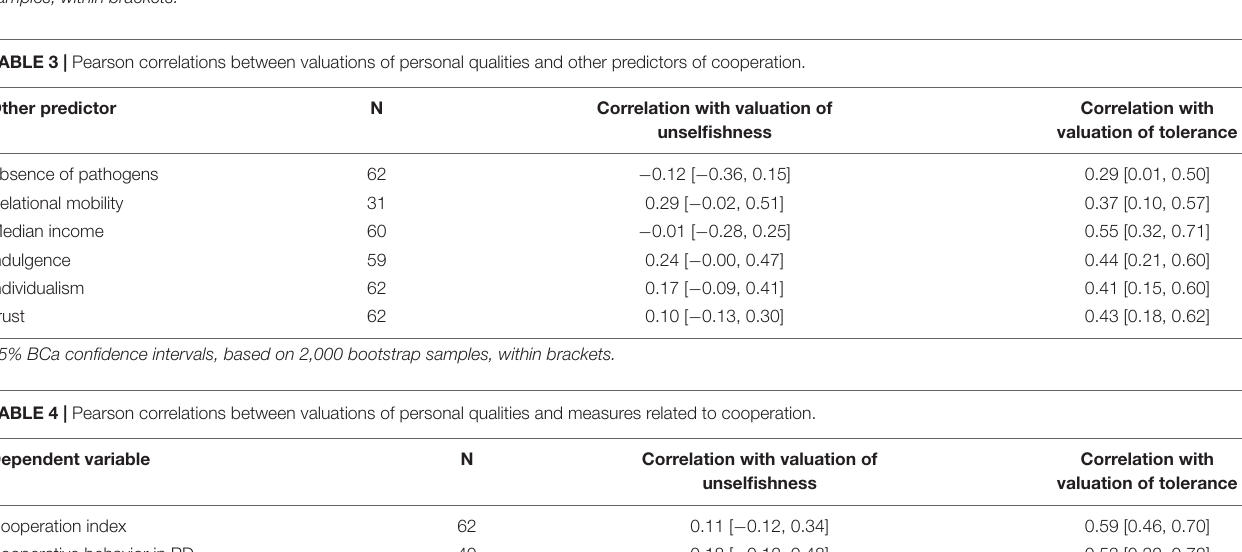
Correlation with unselfishness valuation of